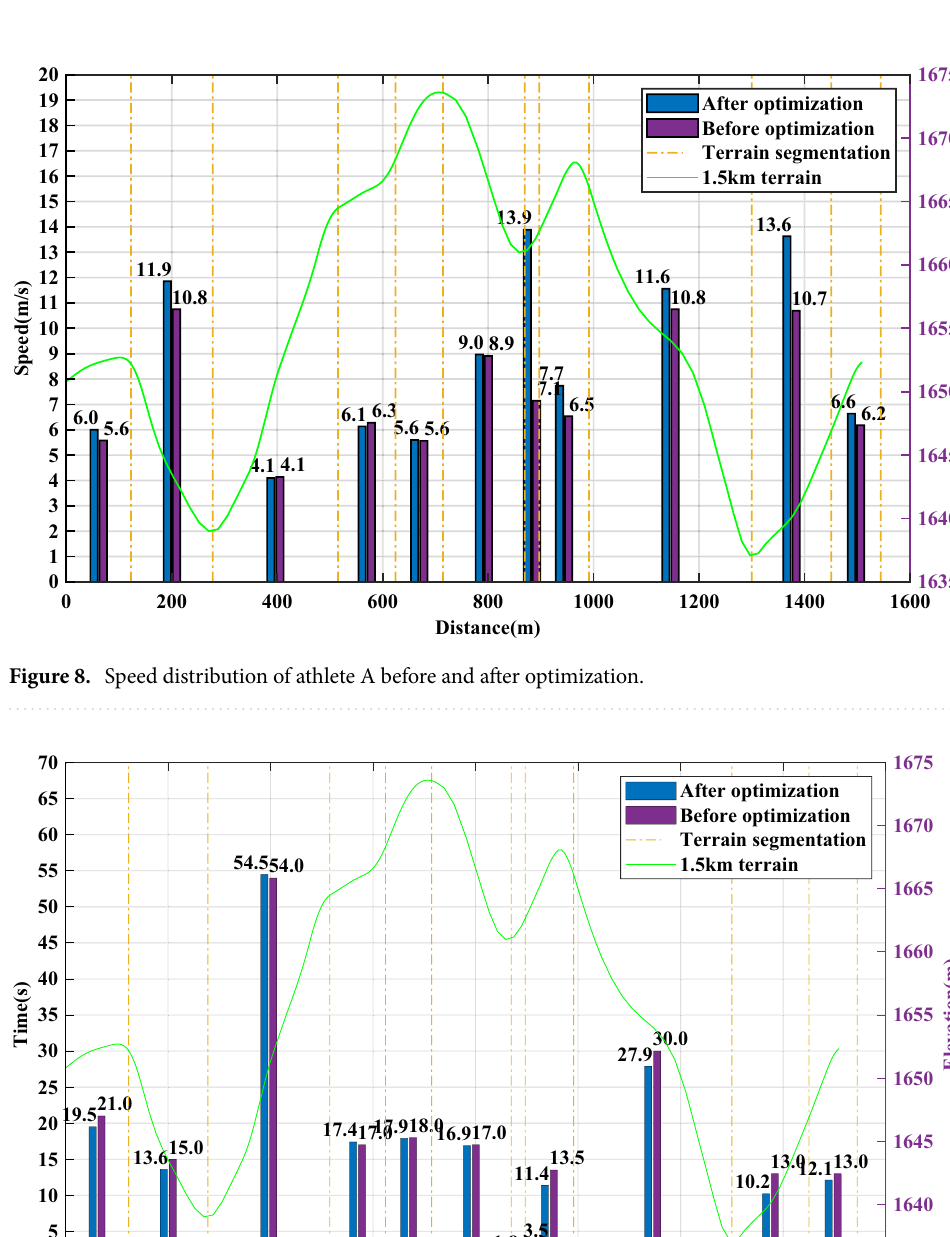
Table 1. Comparison of race data of athlete A before and after optimization.